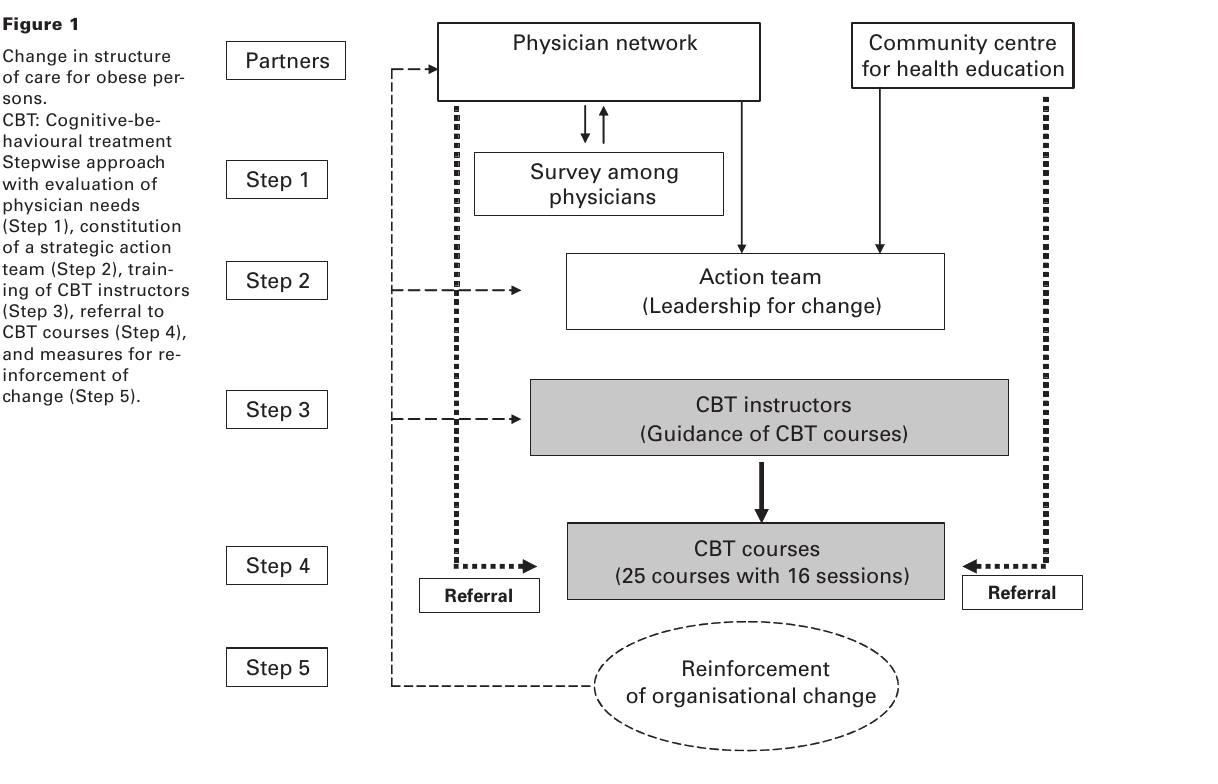
Figure 1 Change in structure of care for obese per- sons. CBT: Cognitive-be- havioural treatment Stepwise approach with evaluation of physician needs (Step 1), constitution of a strategic action team (Step 2), train- ing of CBT instructors (Step 3), referral to CBT courses (Step 4), and measures for re- inforcement of change (Step